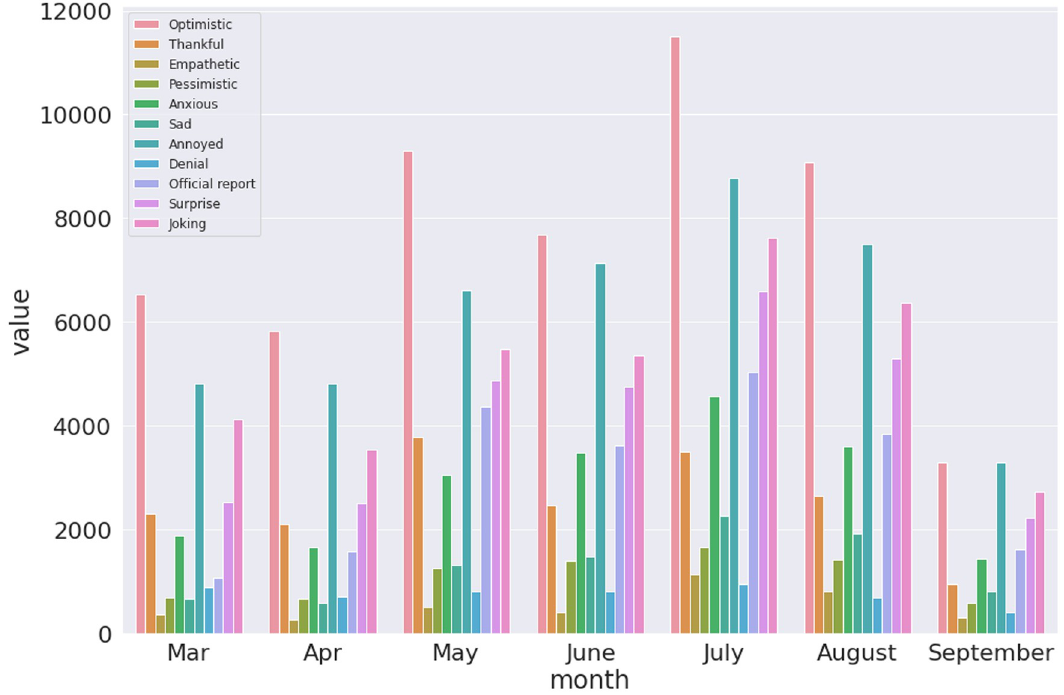
Fig 10. Monthly COVID-19 sentiments in India using the BERT model.